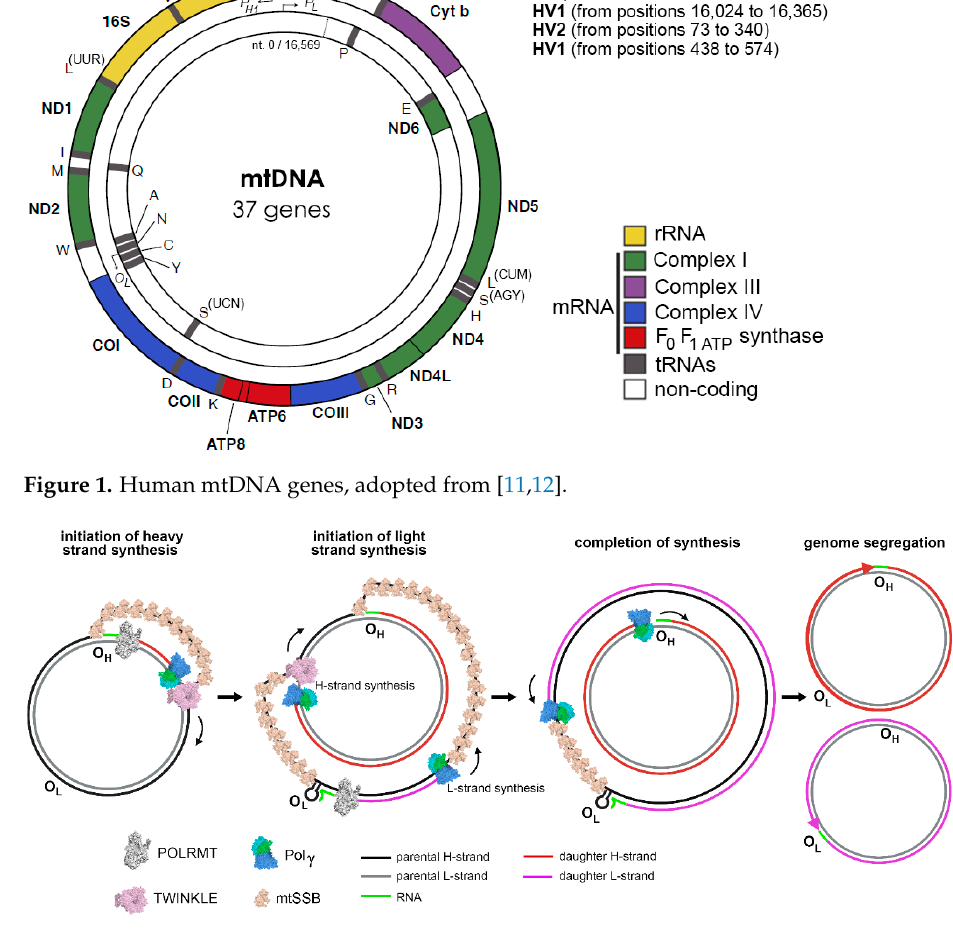
Figure 2. mtDNA replication: initiation and completion of synthesis in strand-displacement fashion, adopted from [16].